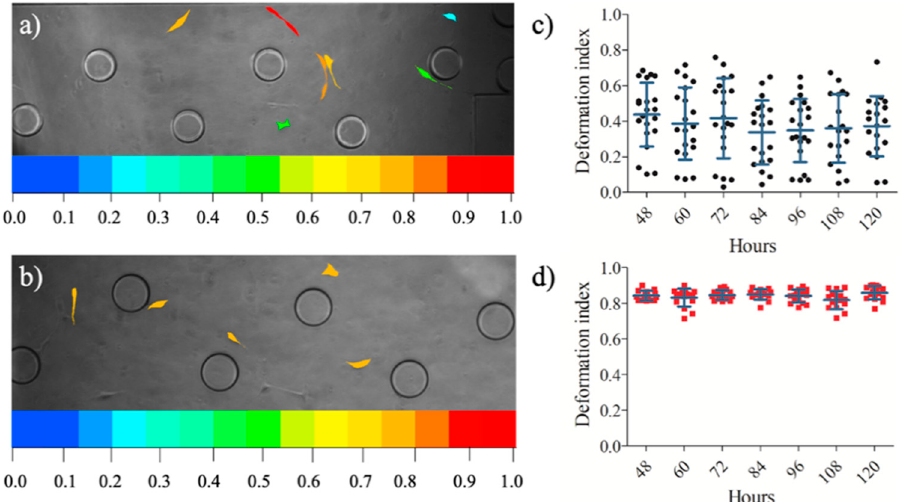
Figure 5. Deformation indexes of the cells in the microfluidic device. The phase images of the cells with a colorimetric deformation scale, the range of deformability from coolest colors (blue: 0) to warm colors (red:1) represent enhanced deformability indexed ( a ) U87 population, ( b ) U87-C population. The deformation indexes of 20 glioma cells between 48- and 120-h ( c ) for U87 population, ( d ) for U87-C population. The data presents the mean ± standard error.